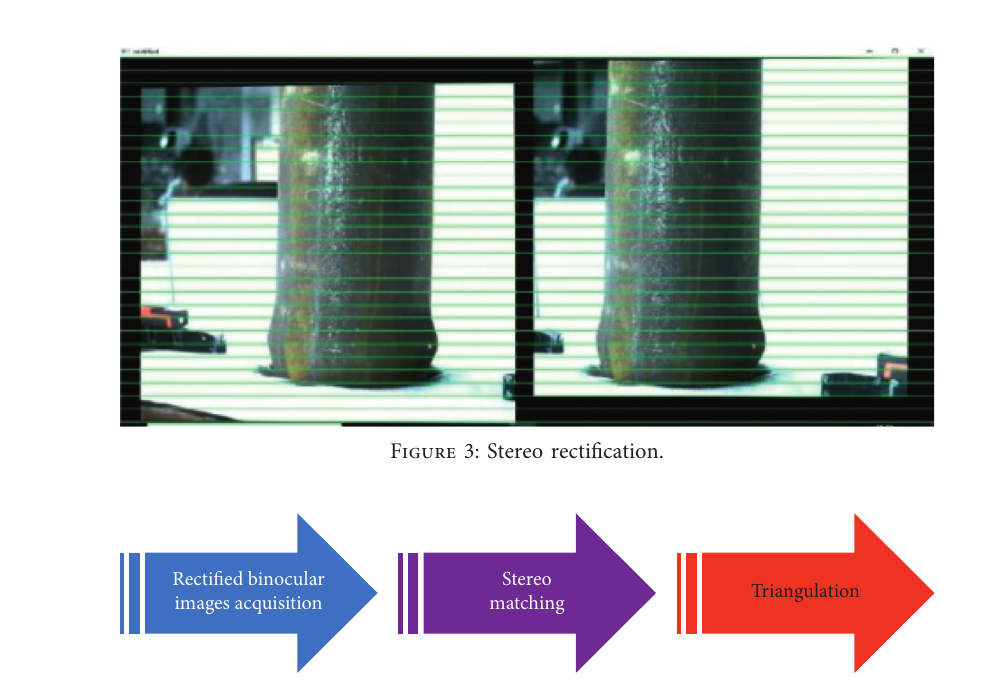
Figure 2: Circle grid: various poses for stereo calibration.